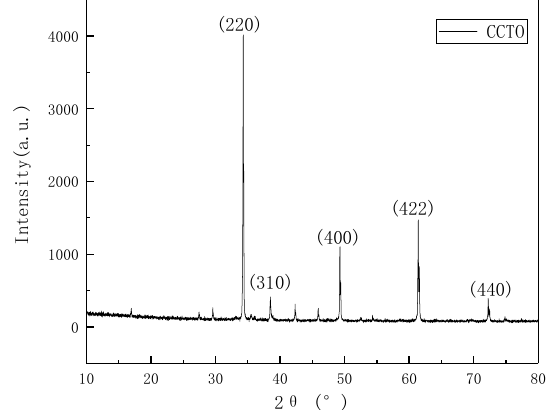
Figure 2. XRD spectrum of unmodified copper calcium titanate (CCTO).